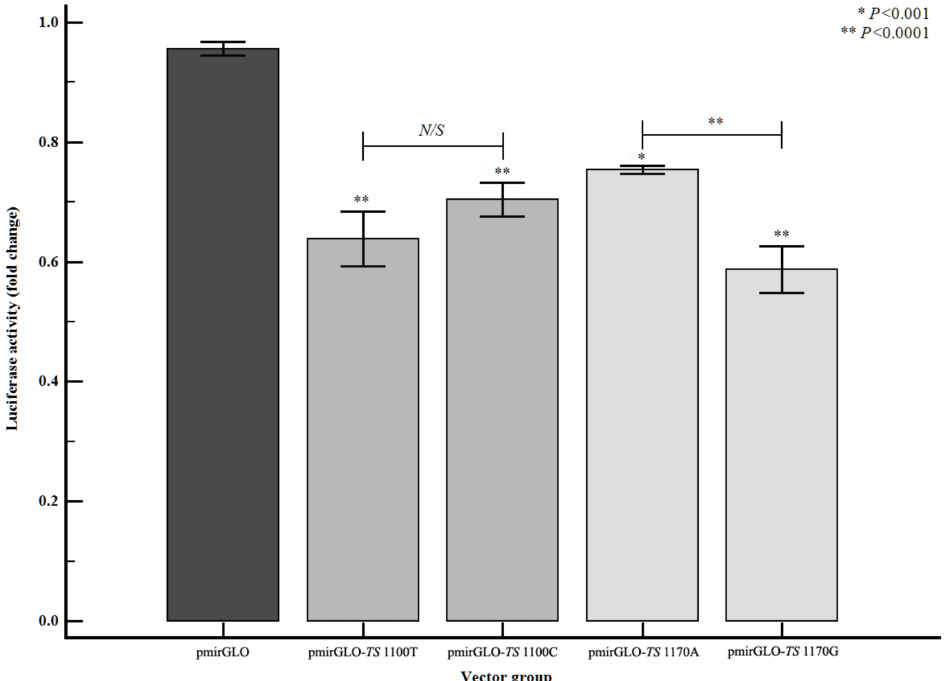
Figure 2. Regulation of TS gene expression in the presence of TS 3 (cid:48) -UTR polymorphisms in EA.hy926 cells. Luciferase activity was measured according to the TS 3 (cid:48) -UTR polymorphisms: 1100T, 1100C, 1170A, and 1170G. Luciferase activity was decreased by each polymorphism compared to the pmirGLO positive control (vs. pmirGLO-TS 1100T, P < 0.0001; vs. pmirGLO-TS 1100C, P < 0.0001; vs. pmirGLO-TS 1170A, P < 0.001; vs. pmirGLO-TS 1170G, P < 0.0001). The expression level of the 1170G allele was significantly reduced compared to the A allele (P < 0.0001). Note; ‘*’ and ‘**’ where the line for the comparison object is not indicated are the indications of the p -value obtained by comparing with pmirGLO, and N/S is an abbreviation of no